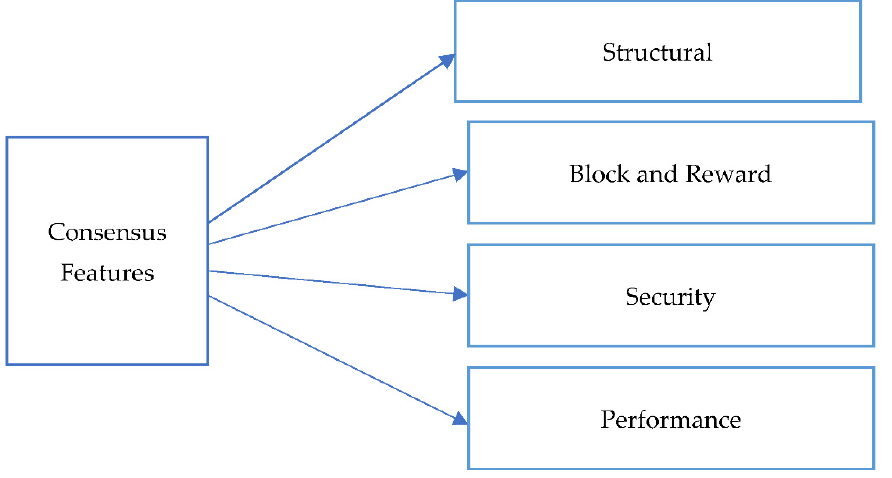
Figure 2. Four features of the consensus mechanism.